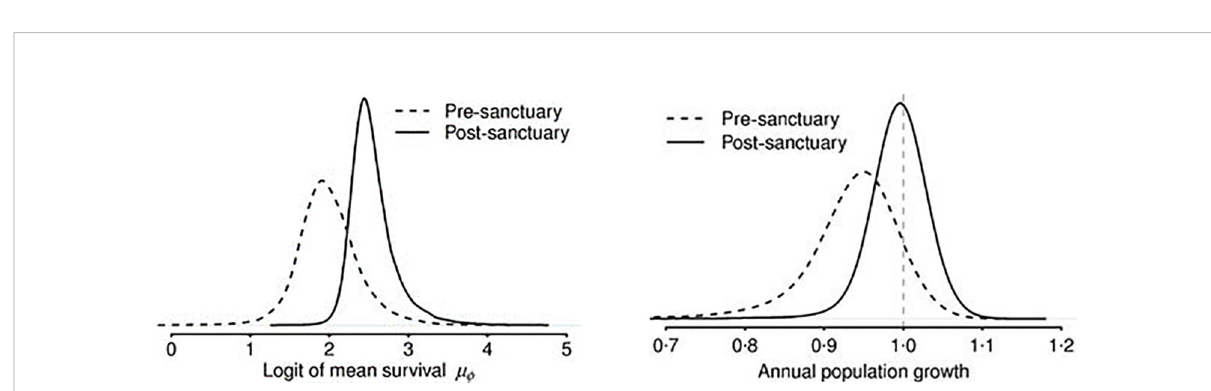
FIGURE 6 Hector ’ s dolphin count in the Banks Peninsula Marine Mammal Sanctuary. Source: Own elaboration, data amended from Gormley et al. (2012).